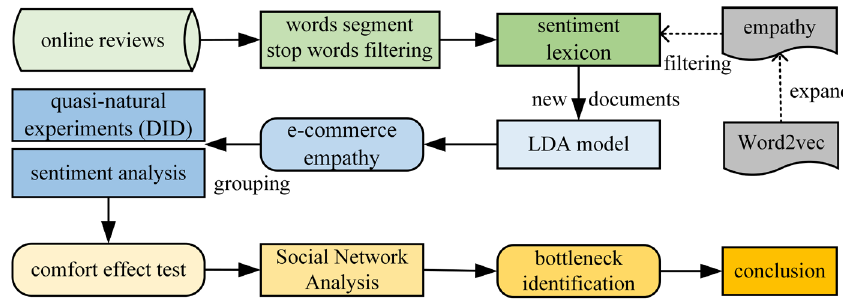
Figure 1. Research Figure 1. Research framework.